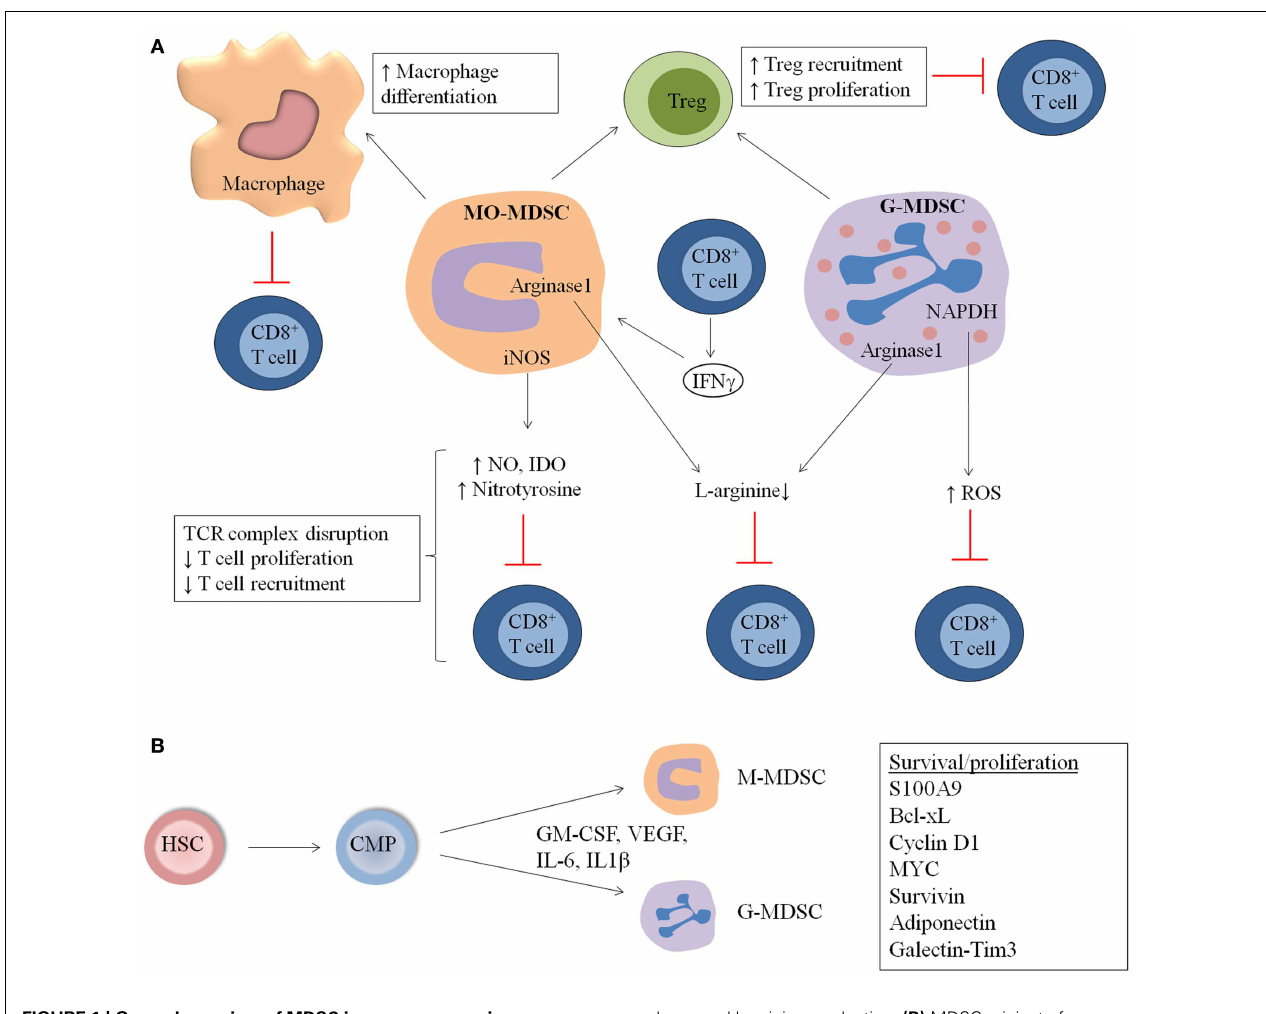
FIGURE 1 | General overview of MDSC immunosuppressive mechanisms and expansion in hematological malignancies and during stem cell transplantation (SCT) . (A) MDSC suppress the immune system by distinct mechanisms including increased macrophage differentiation and regulatoryT cell (Treg) proliferation, direct actions of MDSC onT cells by increased NO, nitrotyrosine and ROS secretion, and